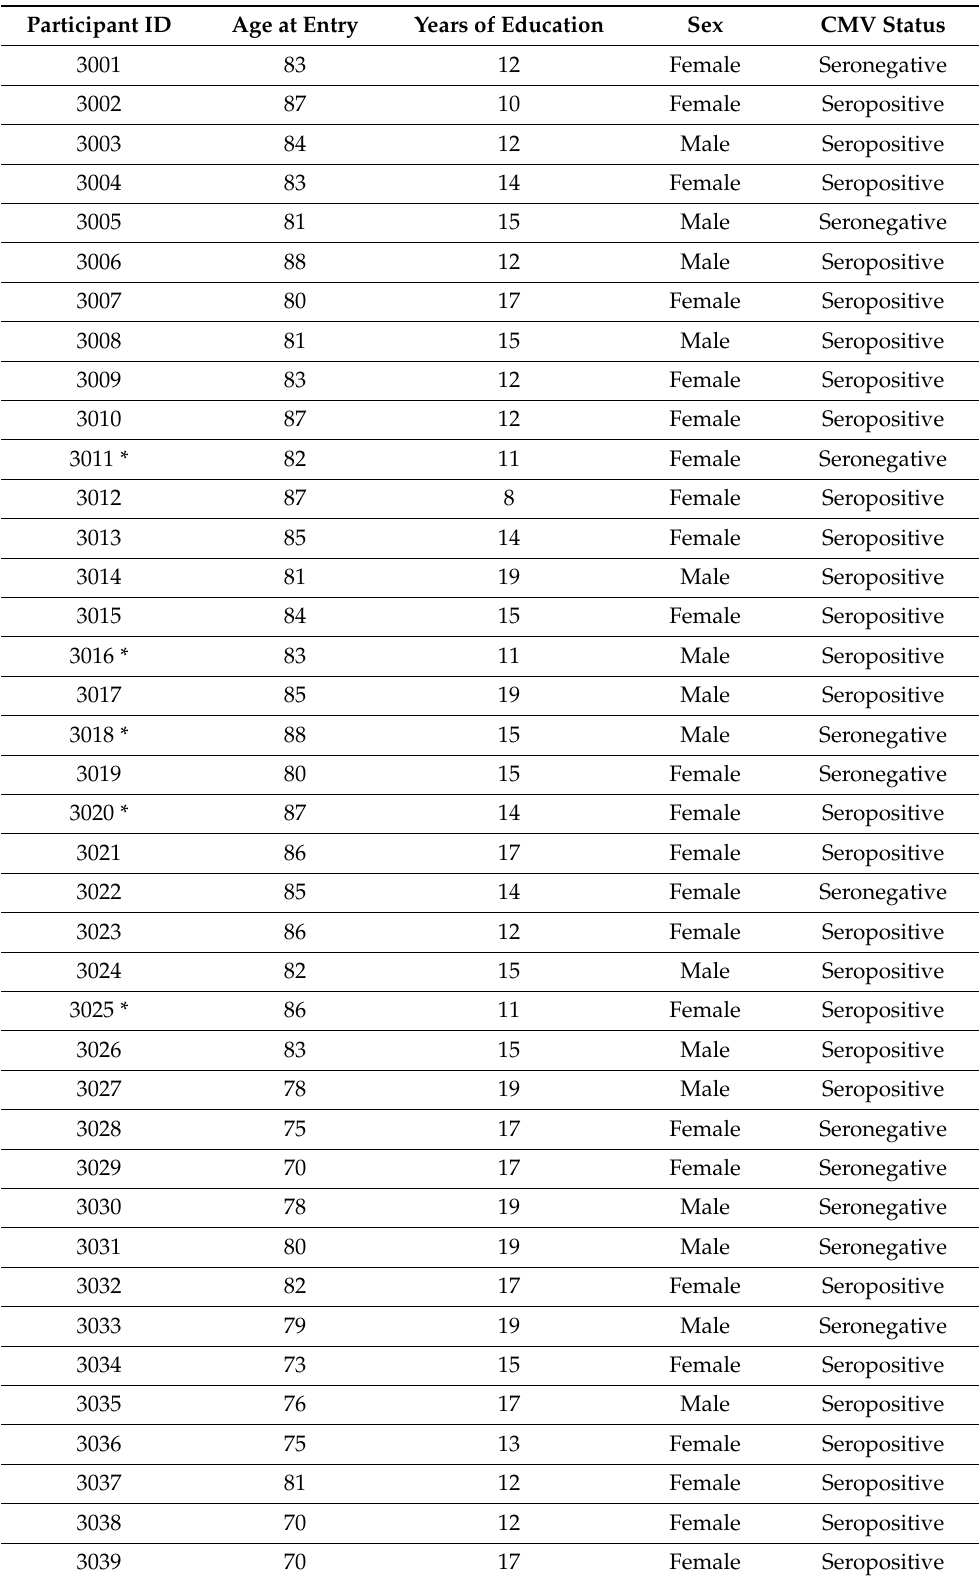
Table 1. Study participant general